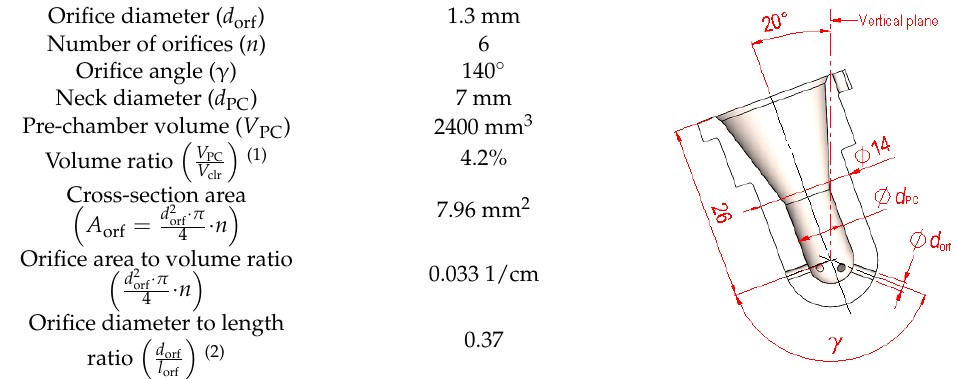
Figure 3. Pre-chamber position in cylinder head.